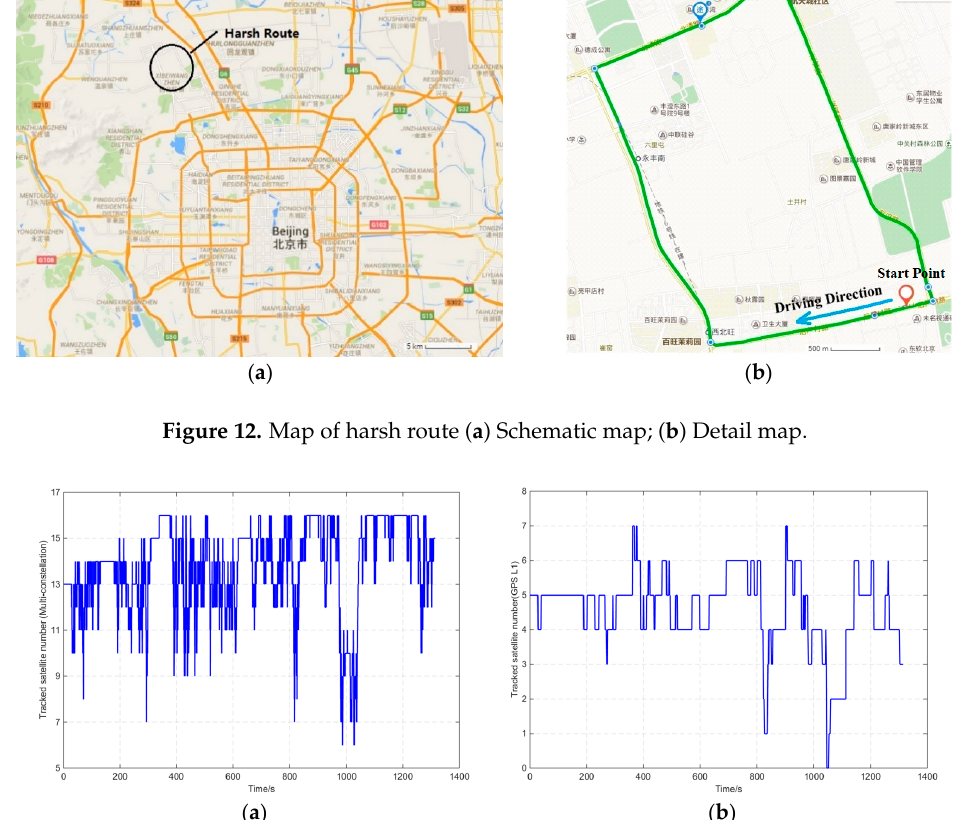
Figure 13. Number of tracked satellites for the harsh route. ( a ) GI7660; ( b ) Demo and compared setup.